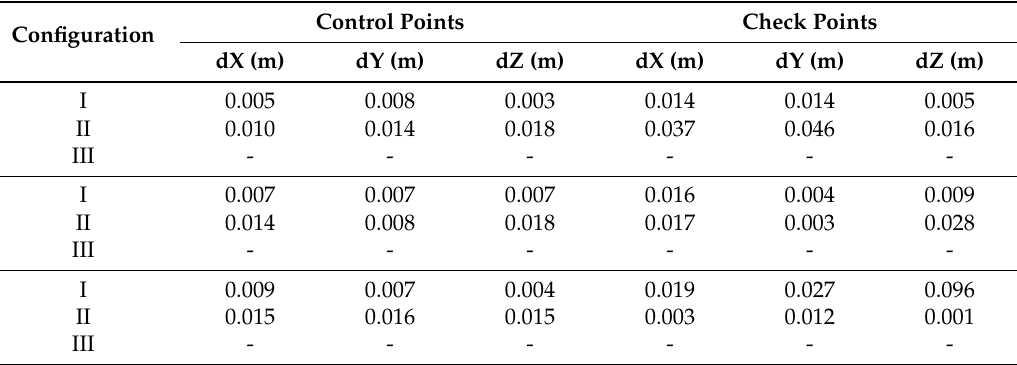
Table 7. Differences between the linear exterior orientation parameters determined using different control point distribution configurations: I and